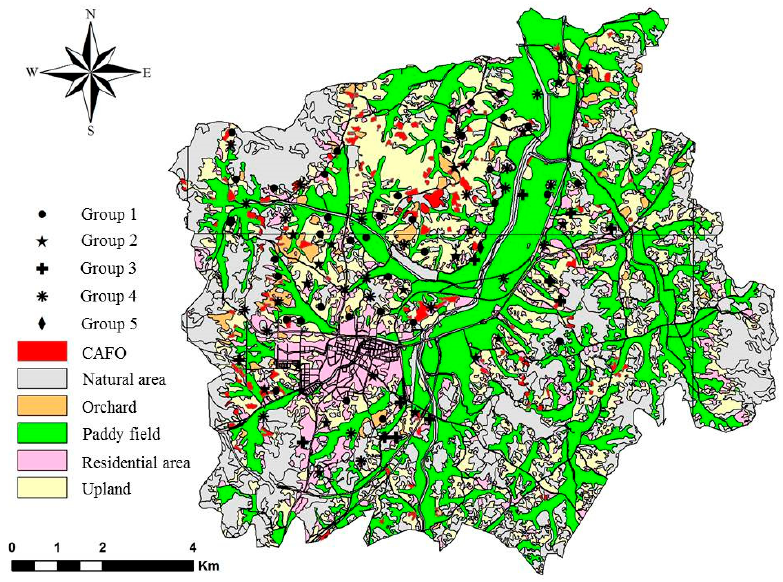
Figure 6. Distribution of the clustered groups on a land use map.